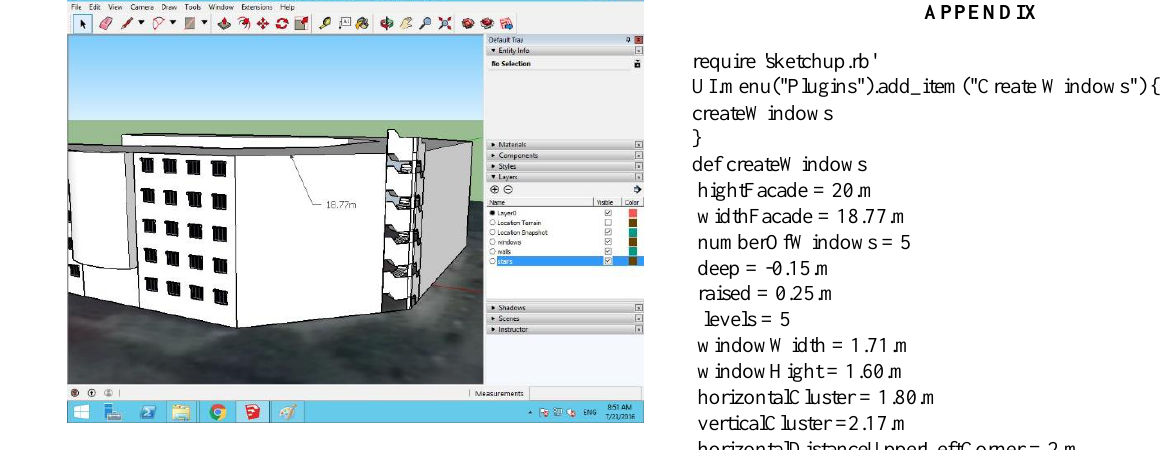
Figure 7. Width of the façade for automatic 3D modelling